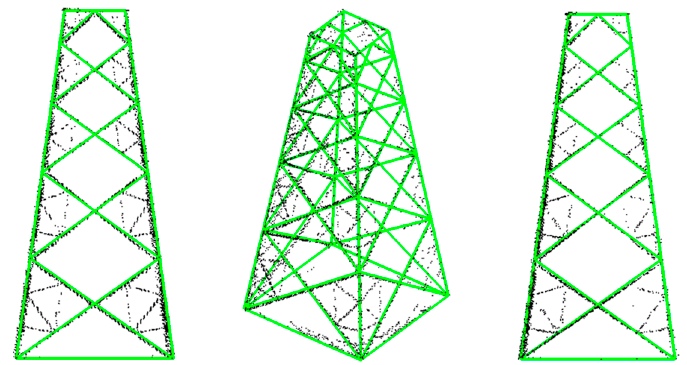
Figure 18. The model of the quadrangular frustum pyramid.